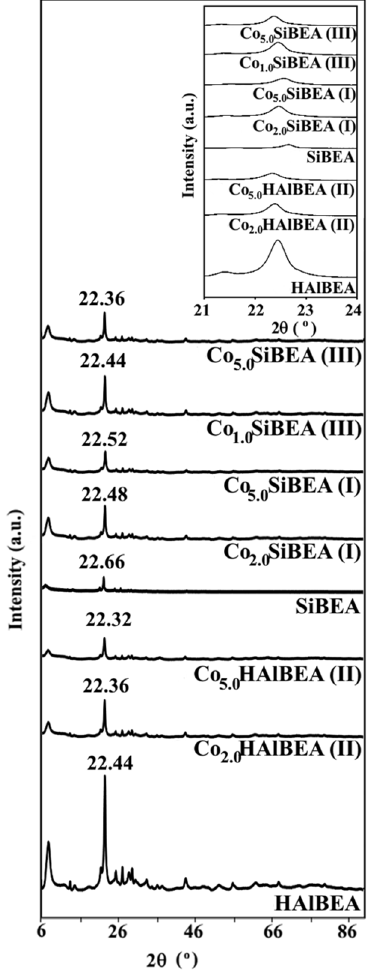
Figure 1. XRD patterns of selected samples of three Co x SiBEA(I), Co x HAlBEA(II), and Co x SiBEA(III) series recorded at room temperature and under ambient atmosphere.